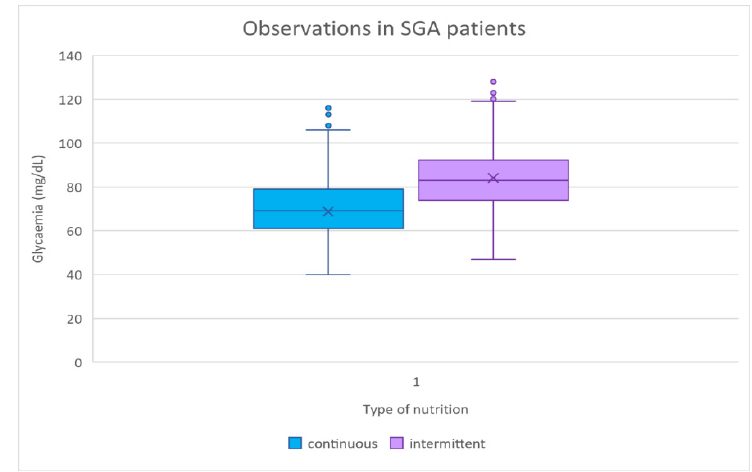
Figure 8. Glycemic observations in SGA patients. SGA, small for gestational age.